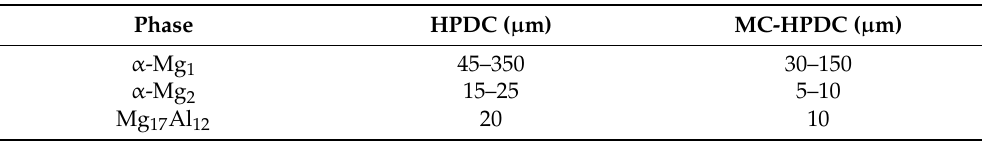
Figure 8. SEM images of ( a , d ) primary α -Mg and eutectic Mg defect bands observed in die-cast microstructures produced by ( a – c ) HPDC and ( d – f ) MC-HPDC, respectively. Reprinted with permission from Ref. [44]. Copyright 2022, Elsevier. Table 1. Size of primary α -Mg 1 grains, primary α -Mg 2 grains, and eutectic Mg 17 Al 12 phases observed in die-cast AZ91D alloys produced by HPDC and MC-HPDC